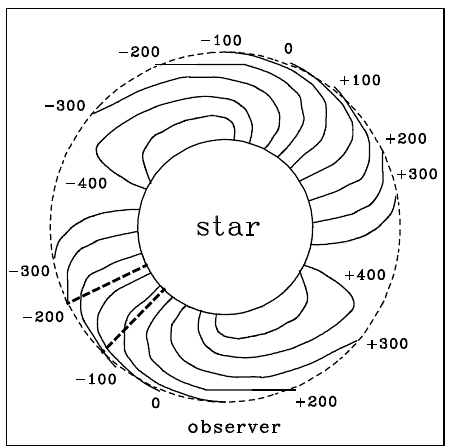
Figure 13. The same as Figure 12, but for the MA model. The parameters of the model are indicated in Section